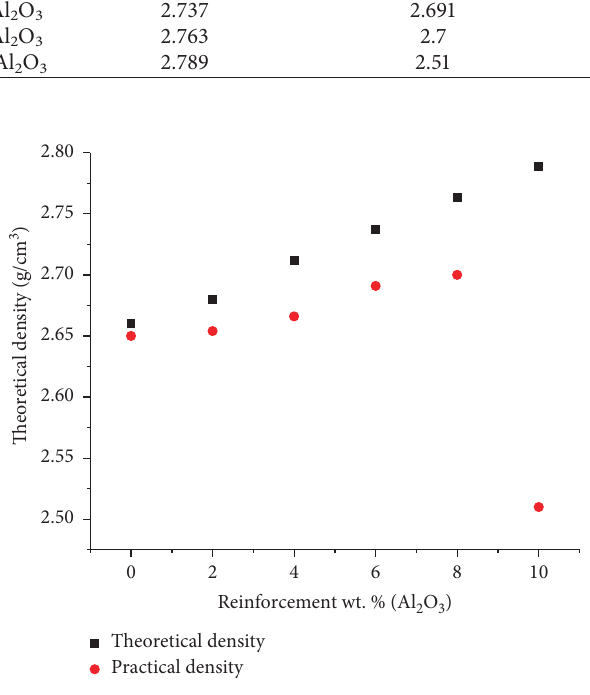
Figure 5: Density v/s reinforcement